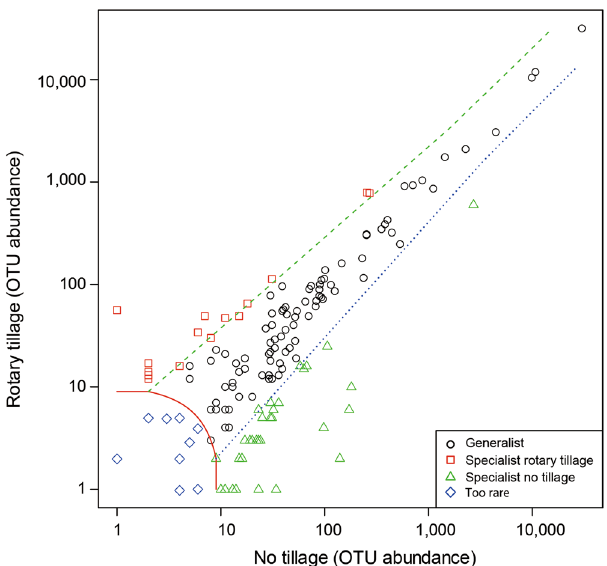
Figure 5. Multinomial species classification of taxa in the maize roots grown under rotary tillage and no tillage. The operational taxonomic units (OTUs) of arbuscular mycorrhizal fungi (AMF) common to both rotary tillage and no tillage are represented by circles; those observed only in rotary tillage are represented by squares, and those observed only in no tillage are represented by triangles. Diamonds represent rare AMF OTUs. All analyses and Fig. 5 were run and created in the software environment RStudio (Version 1.2.1335 – © 2009–2019 RStudio, Inc.)